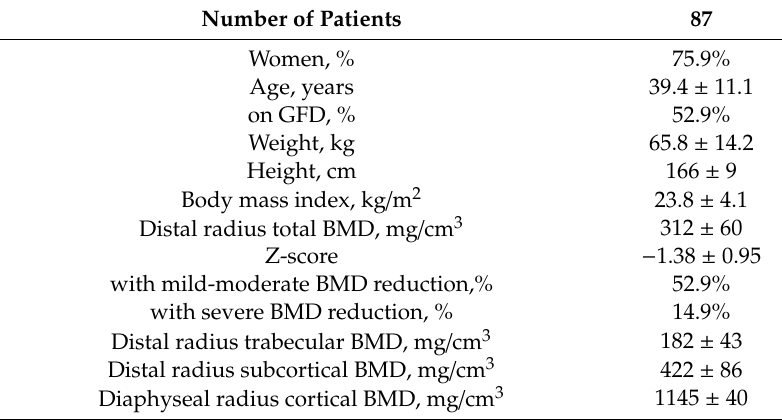
Table 4. Descriptive statistics for the 87 patients with peripheral quantitative computed tomography (pQCT) assessment of radius bone mineral density: Mean ± SD or